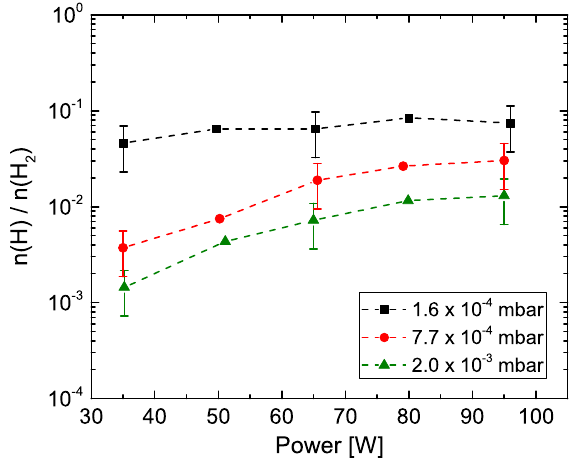
FIG. 6. Density ratio of atomic to molecular hydrogen obtained from the OES evaluations for varying power at different pressures ¼ 0 . 56 . =B and fixed ratio B min ECR